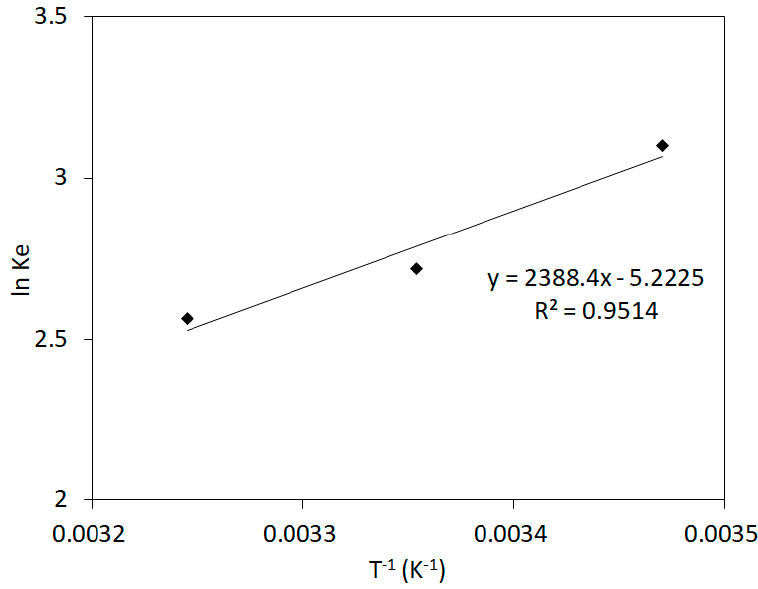
Figure 5. Van’t Hoff plot for Sb(V) adsorption by Fe-CMB. Table 4. Enthalpy, entropy, and Gibb’s free energy for the adsorption of Sb(V) by Fe-CMB. Temp.